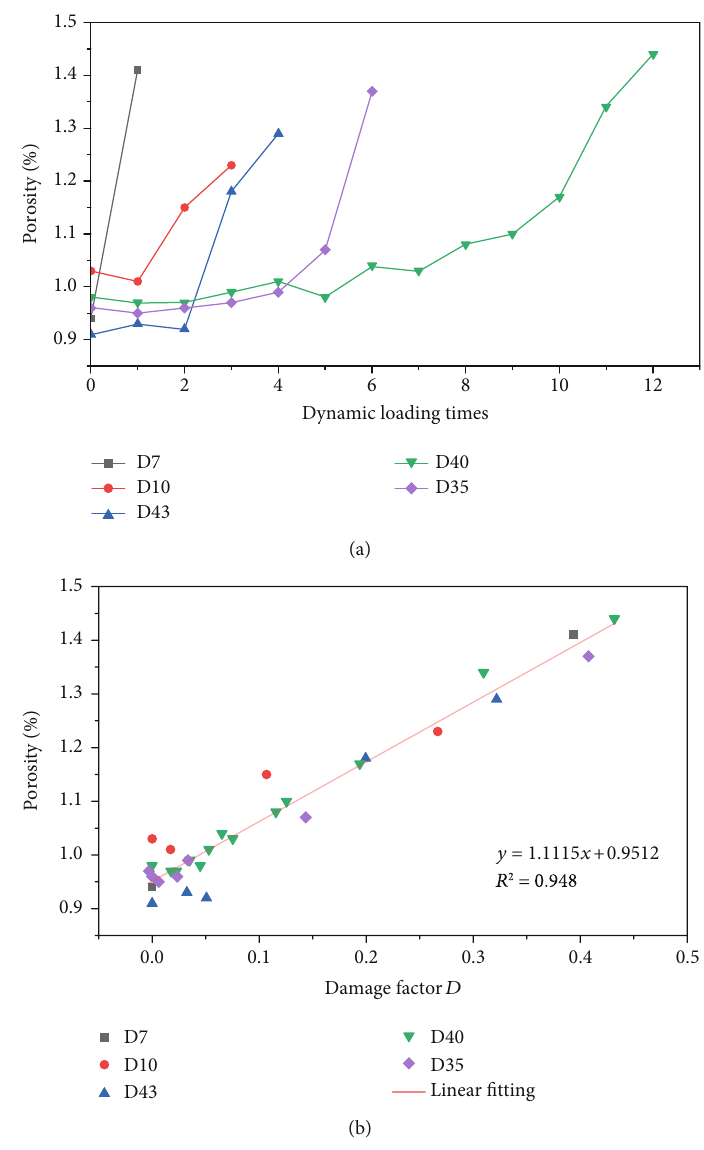
Figure 13: (a) Relationship between dynamic loading times and the porosity under di ff erent loading velocities and (b) relationship between the damage factor and the